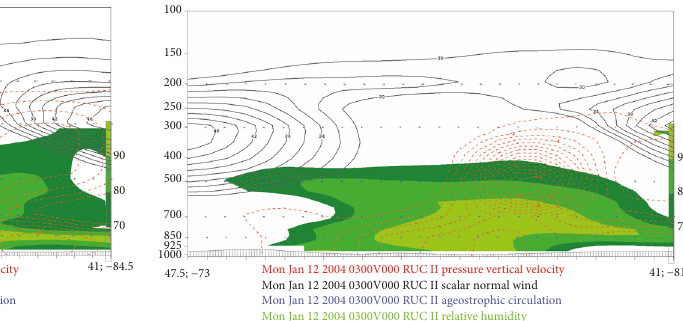
(c) As in Figure 7(a), except valid at 0000 UTC 12 January 2004 (d) As in Figure 7(a), except valid at 0300 UTC 12 January 2004